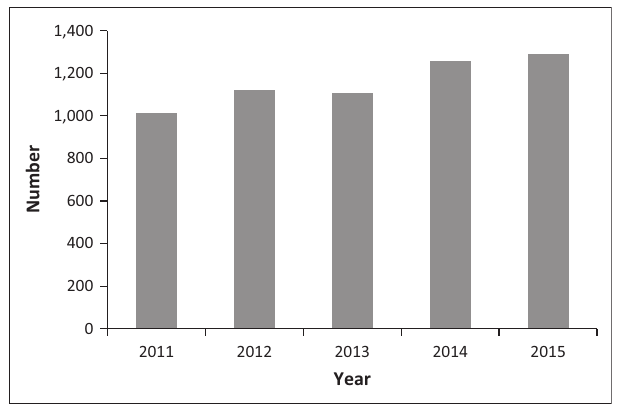
FIGURE 1: Number of diagnostic IFAT for canine Leishmania per year (2011–2015); dogs intended for importation into South